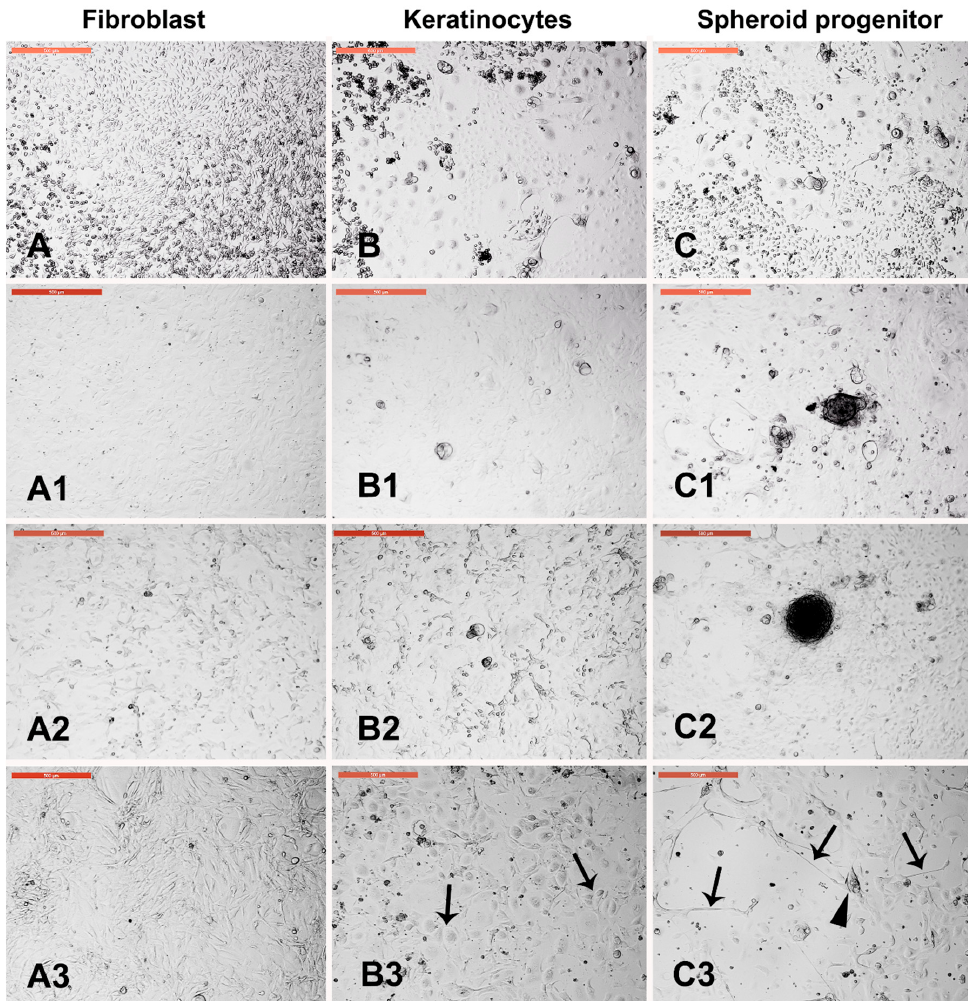
Figure 4. Sensitivity of different trypsin-sensitive skin-derived cells to heat shock. Dissociated fibroblasts ( A ), keratinocytes ( B ), and fluid filled cysts and clumps ( C ) were collected after 1.5, 4.5, and 7 min of trypsinization, respectively, washed in PBS, and cultured in new culture dishes. ( A1 ) Fibroblast monolayer. ( B1 ) Keratinocyte monolayer. ( C1 ) Fluid-filled cysts and cell clumps (spheroid progenitors). Cells of ( A1 , B1 , C1 ) were exposed to heat shock (45 ◦ C for 2 h). ( A2 ) Fibroblast architecture was disturbed. ( B2 ) Architecture of keratinocytes was partially distorted. ( C2 ) Spheroid progenitors and the surrounding cells were resistant to heat shock. ( A3 , B3 , C3 ) show the corresponding cells after recovery at 38 ◦ C for 4 days. ( A3 ) Fibroblasts recovered and reached confluency. ( B3 ) Keratinocytes recovered with increased nuclear size (arrows). ( C3 ) Spheroid progenitors recovered with spontaneous di ff erentiation into neuron-like axons (arrows) and cell bodies (arrowheads). Scale bar = 500 µ